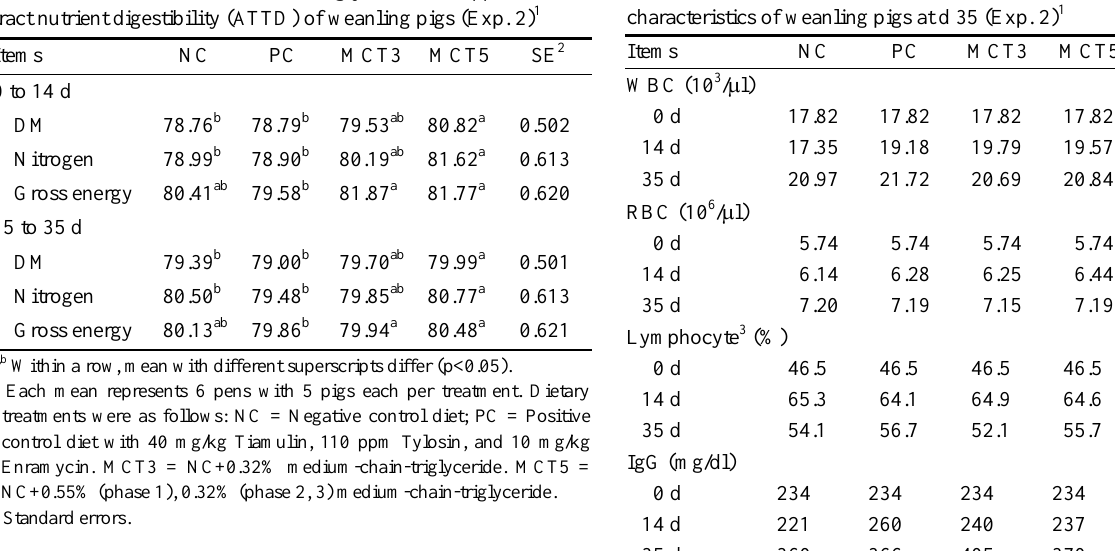
Table 7. Effect of medium-chain-triglyceride on blood characteristics of weanling pigs at d 35 (Exp. 2)